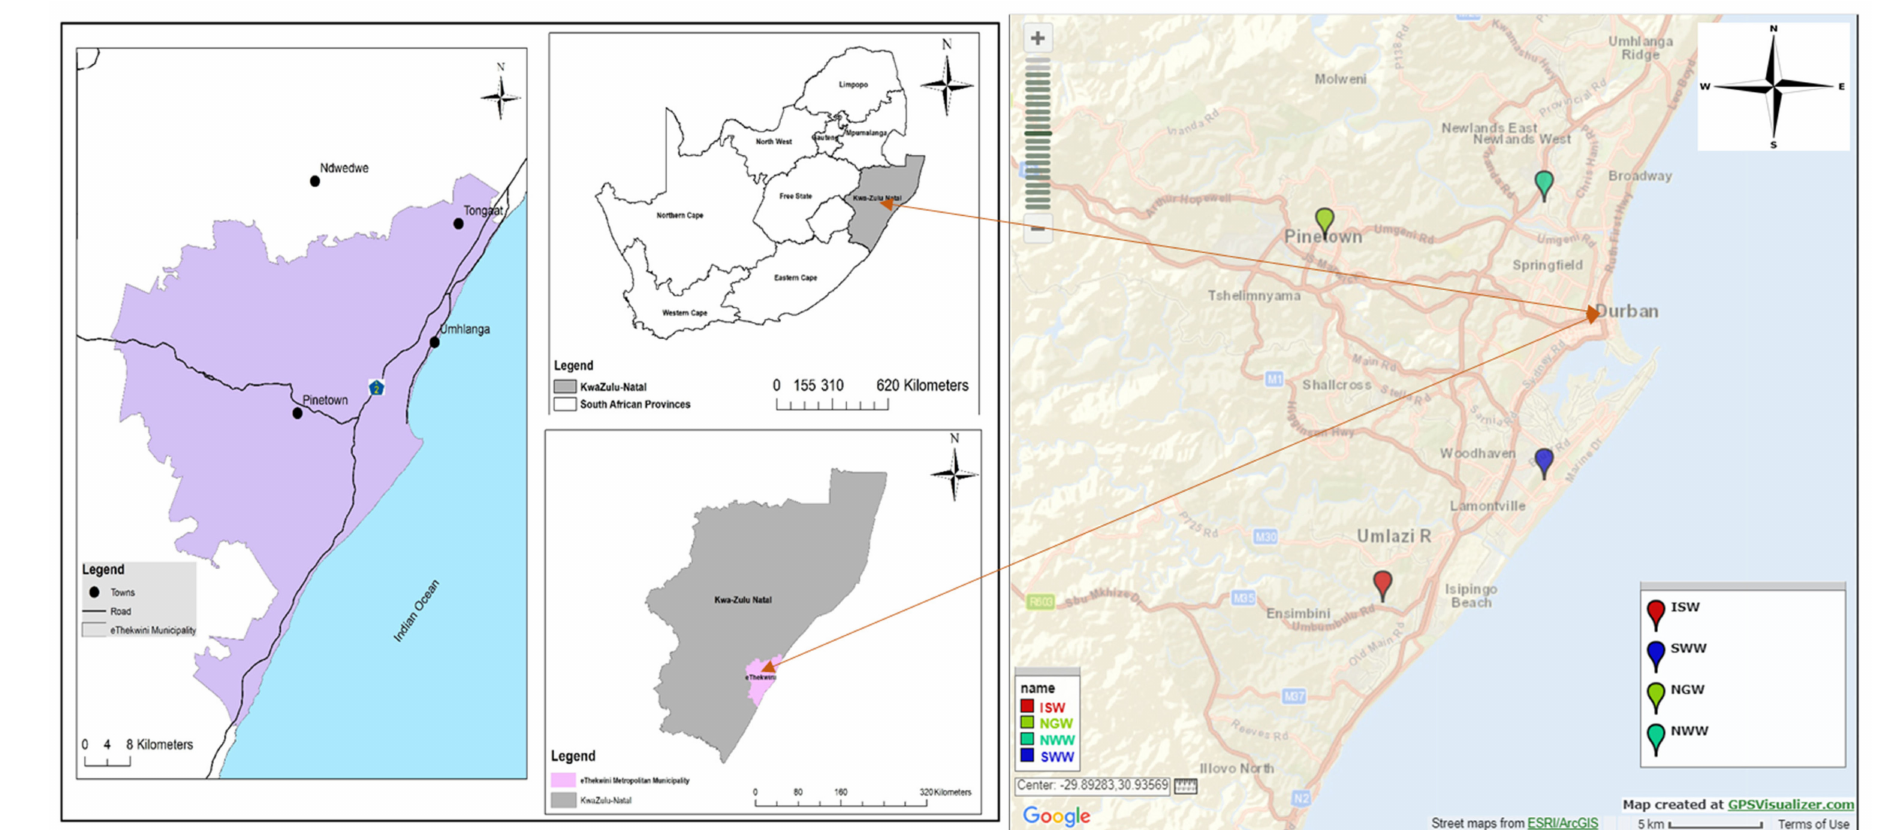
Figure 2. Map showing site locations with wastewater treatment plants across the Durban